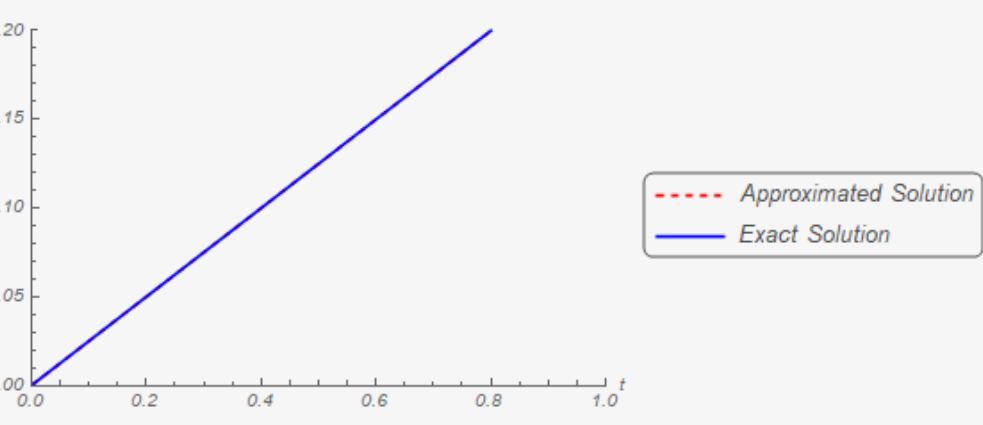
Figure 14. The second component of the exact solution and its three hundredth approximation. The following inequalities are related with the maximum deviations of the exact solution with its three hundredth